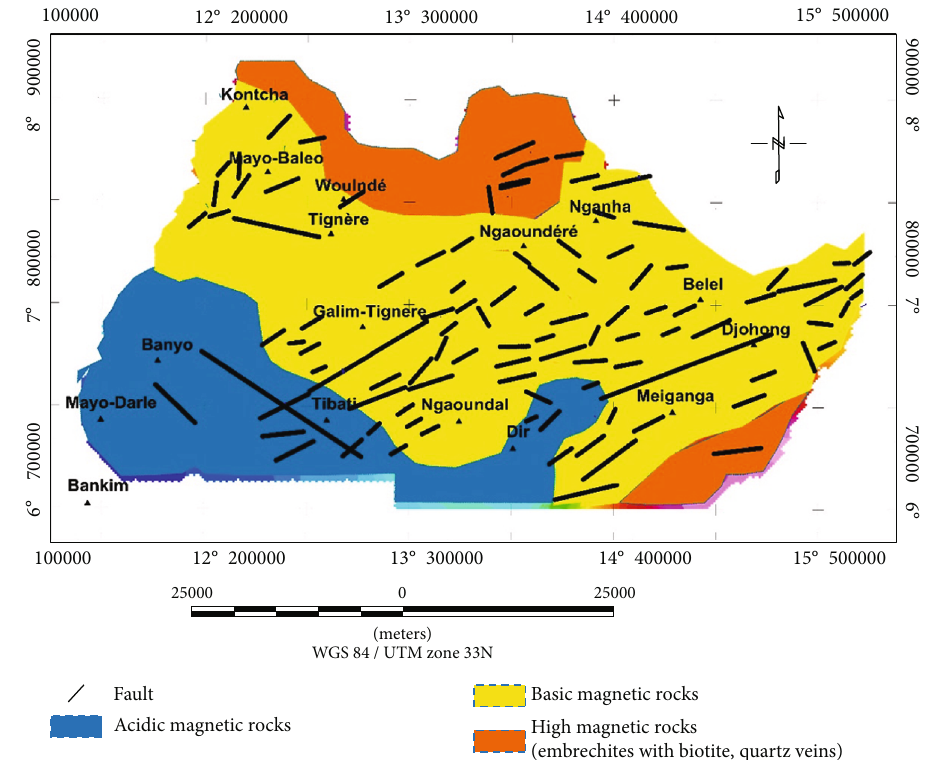
Figure 11: Tectonic map of the magnetic basement from the faults of map from